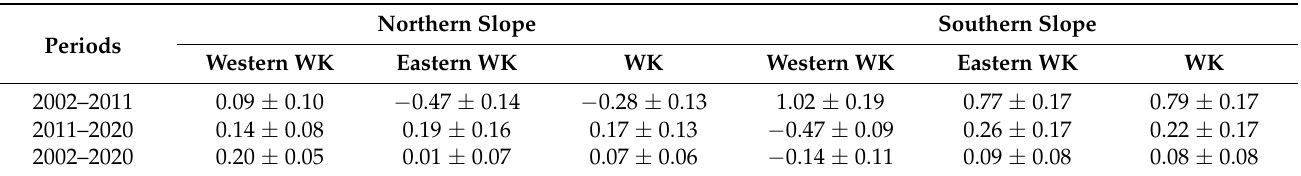
Table 3. Spatial variations of glacier SMB in northern and southern slopes of WK and its two subregions over three different time spans. (unit: m w.e. a − 1 ). Northern Slope Southern Periods